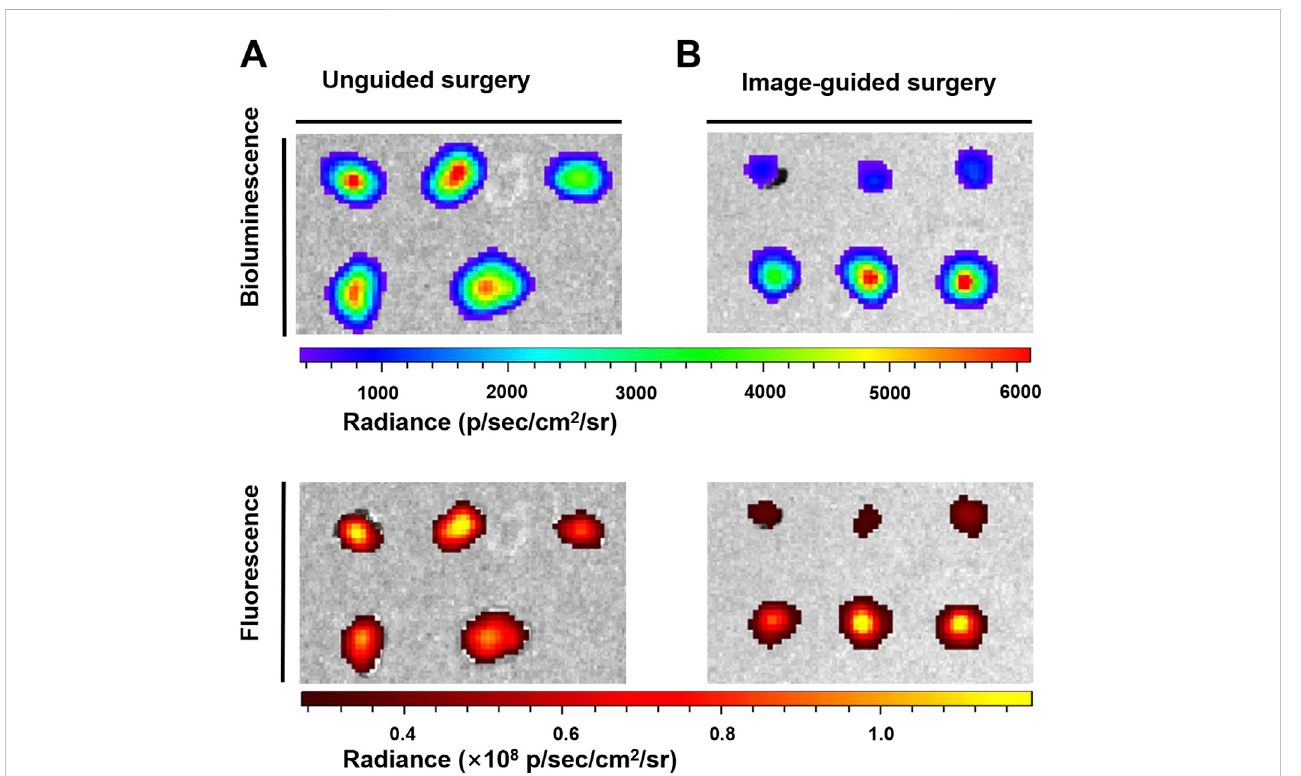
FIGURE 8 Theperitonealcarcinomatosis-bearingmicewereintravenouslyinjectedwith200 μ LofADPHNPs(30 μ MbasedonADHP)followedbytheoperationof the abdomen at 24 h after injection: bioluminescence and fl uorescence images typical of resected tumor nodules (A) post unguided surgery and (B) post the second surgery with guidance of fl uorescence imaging of ADPH